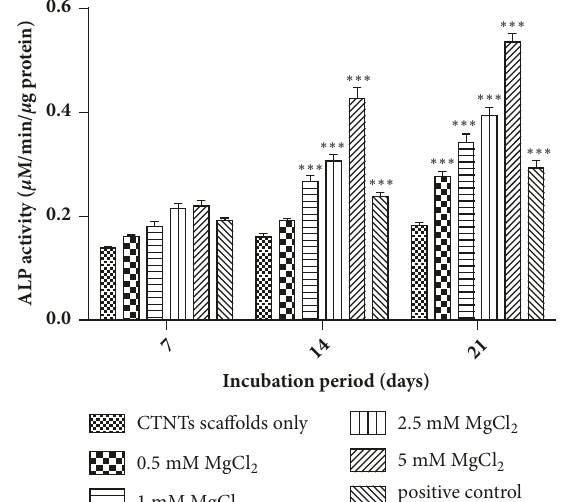
Figure 8: ALP activity of MG63 cells grown on CTNTs scaffolds only, CTNTs scaffolds functionalized with different amounts of Mg 2+ ions and polystyrene well (positive control) on culture periods of 7, 14, and 21 days ( ∗ ∗ ∗ p < 0.001, n =